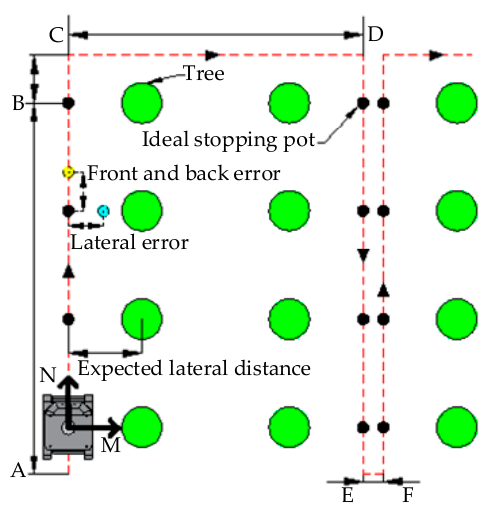
Figure 3. The navigation path.